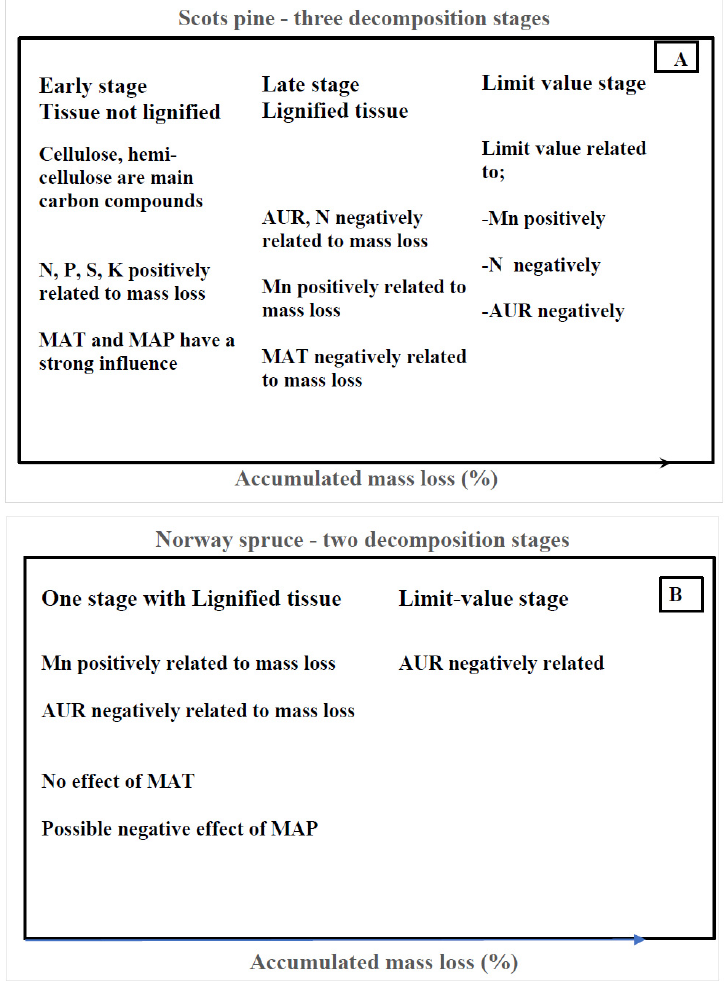
Figure 1. Model for some rate-regulating factors during decomposition of two different litter types in a boreal-to-temperate climate. ( A ) Model for pine species, based on that of Berg and Matzner [3], which subdivides the decomposition process into three stages. The decomposition of water-soluble substances and unshielded cellulose/hemicellulose is stimulated by high levels of a few major nutrients. So far, N, P, S and K concentrations have been found to increase the rate, as well as MAT and AET (early stage, lasting until c. 30% accumulated mass loss). When all unshielded holocellulose is decomposed, only lignin-encrusted holocellulose and lignin/AUR remain. In the late stage, the degradation of lignin rules the litter decomposition rate. Nitrogen hampers the degradation of lignin and higher N concentrations suppress the decomposition, whereas Mn appears to have a stimulating effect on the degradation of lignin and of the lignified tissue. There is no effect or just a small effect of MAT in this phase. Finally, in the humus-near stage, the lignin level is nearly constant, often at a level of 50–55%, the litter decomposition rate is close to zero and the accumulated mass loss also reaches its limit value (Equation (1)). ( B ) Model for Norway spruce litter, subdivided into two phases. For this species, the litter tissue is completely lignified and the decomposition of lignin dominates the decomposition of the cellulose and hemicellulose compounds. There is no effect of MAT on the decomposition rate. The decomposition of water-soluble substances and the lignified cellulose/hemicellulose is stimulated by high levels of Mn. Finally, in the humus-nearphase, the lignin level is nearly constant, often at a level of 50–55%, the litter decomposition rate is close to zero and the accumulated mass loss reaches its limit